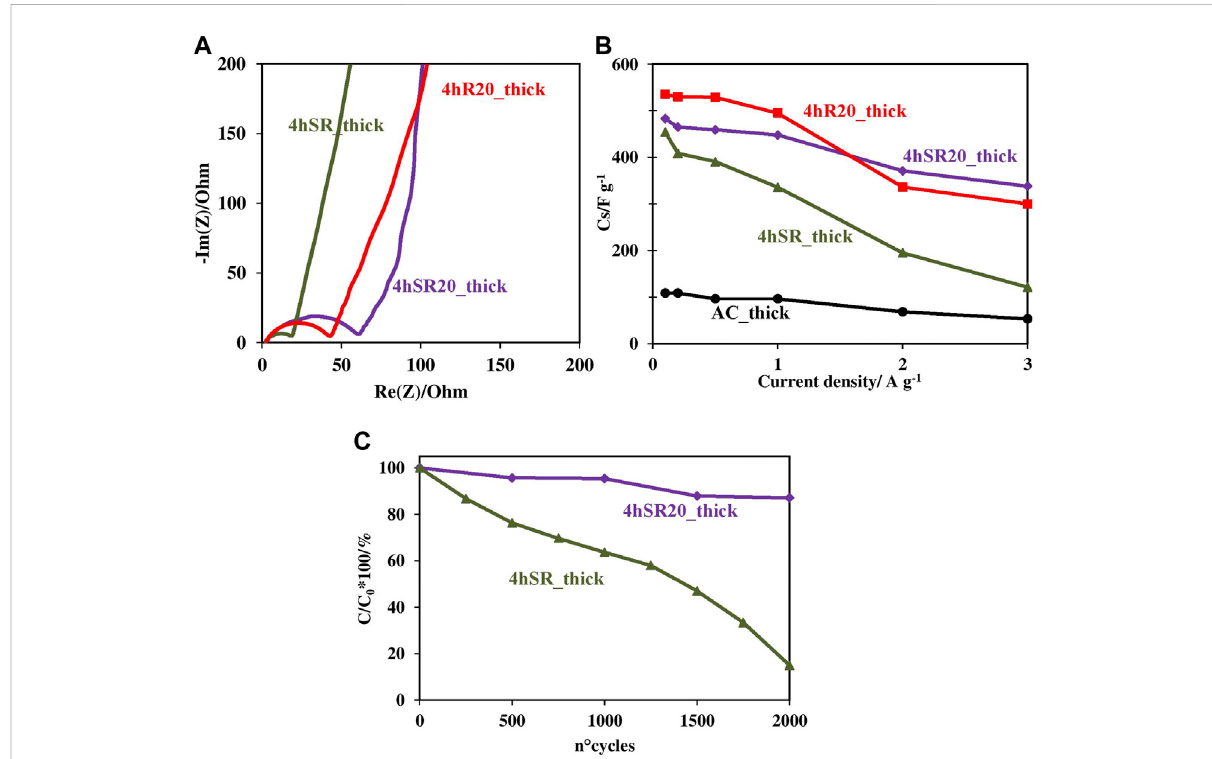
FIGURE 12 Electrochemical characterization of the electrodes based on 4hSR TiO 2 with 20 wt% carbon black (4hSR) and its composite with 20 wt% CNTs (4hSR20)inLiPF 6 EC/PC/3DMCastheelectrolyte: (A) Nyquistplotcomparedtothecomposite4hR20, (B) ratecapabilitycomparedtothecomposite 4hR20 and commercial activated carbon (AC) and (C) cycle performance at a current density of 0.5 A g − 1 . The label “ thick ” after the sample name indicates an electrode mass loading of approximately 9.0 mg cm − 2